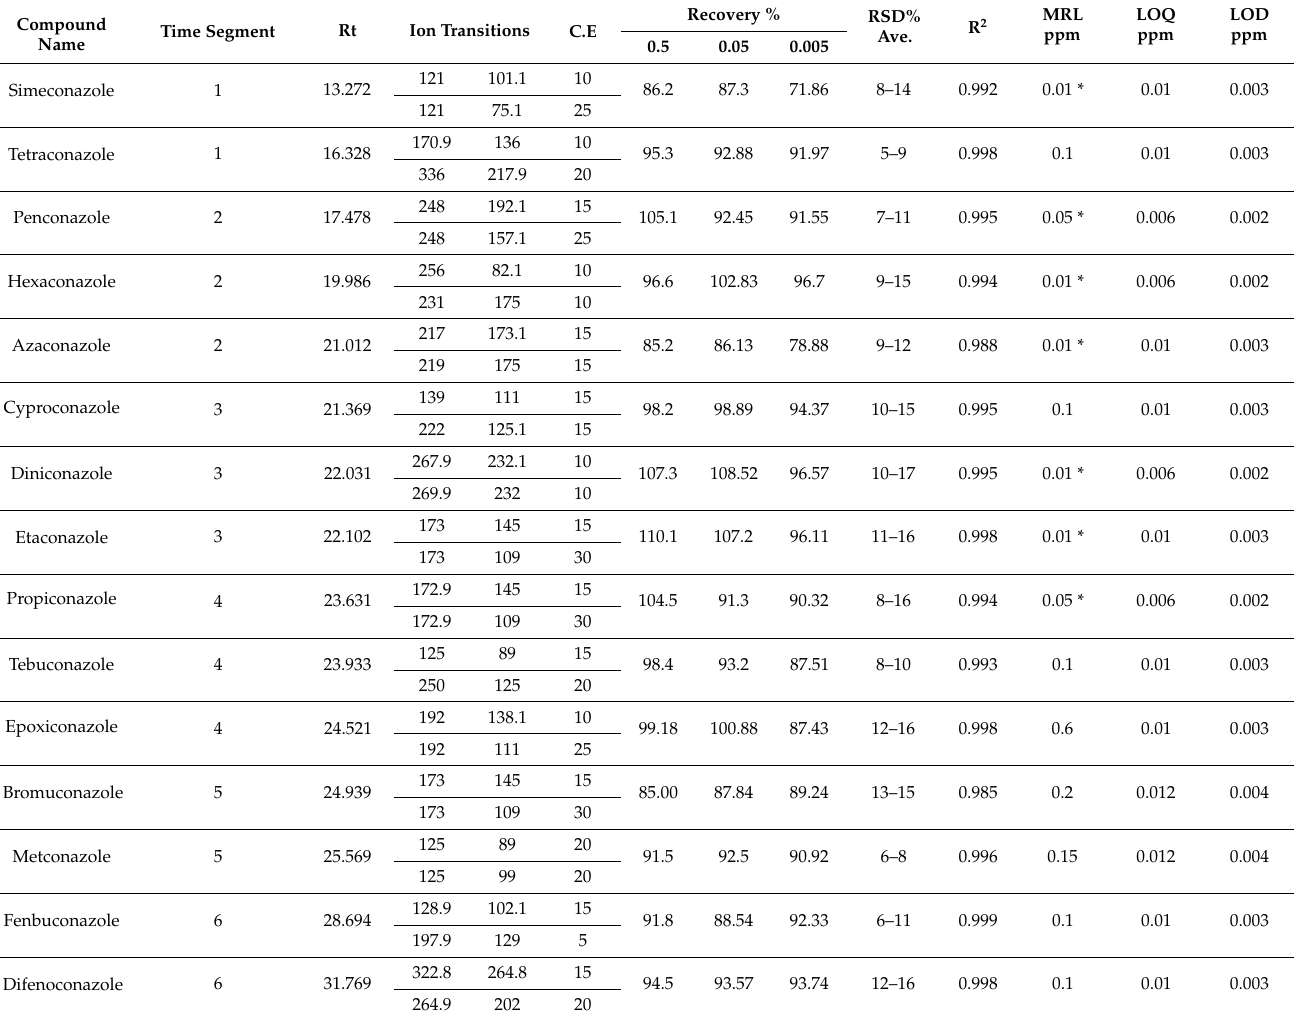
Table 1. Separation and validation data of the studied